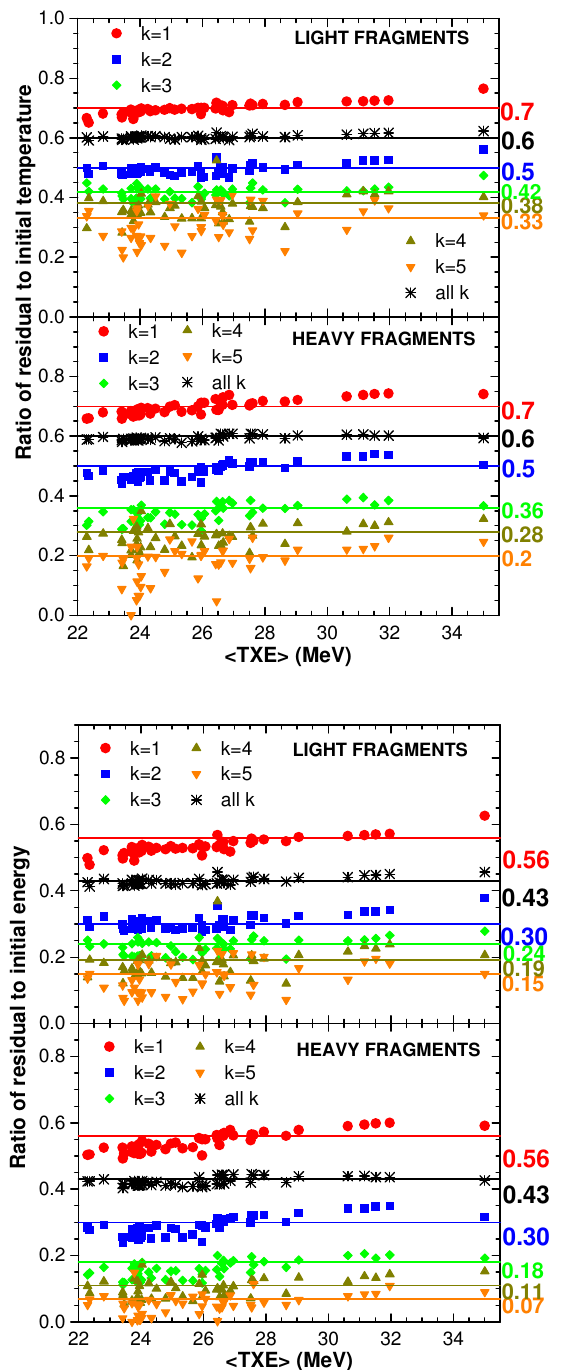
Fig.1 : The ratios of residual temperature (upper part) and residual energy (lower part) to those of initial fragments corresponding to each sequence k (different coloured symbols) and to all emission sequences (black stars) and the constant values approximating these ratios (horizontal lines plotted with the same colour as the respective symbol).